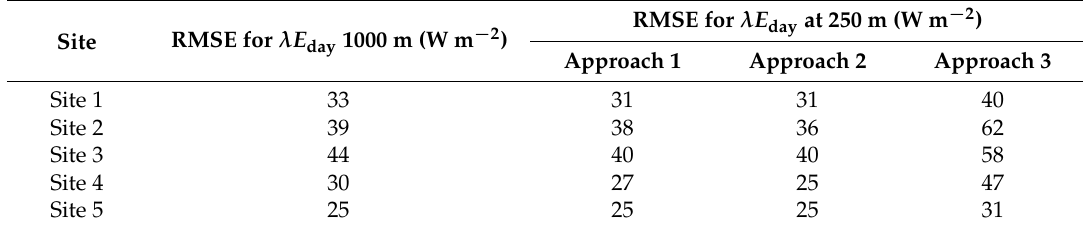
Table 3. Results of the comparison between ground observations and satellite-obtained λ E day .